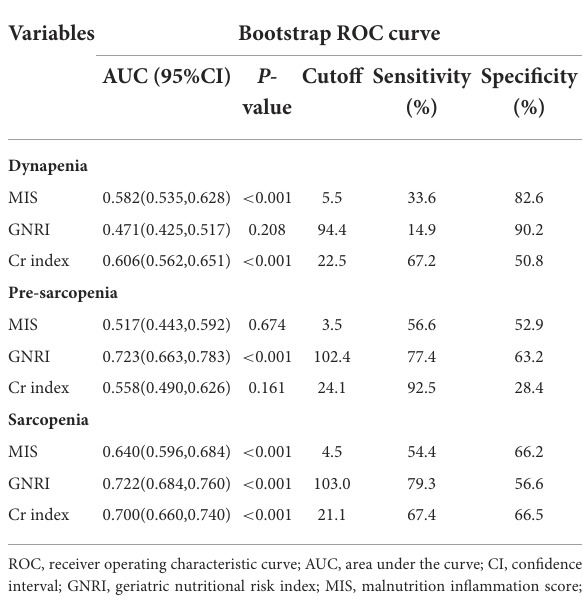
TABLE 2 Receiver operating characteristic curve for the nutritional factors to estimate the probability of dynapenia, pre-sarcopenia, and sarcopenia.